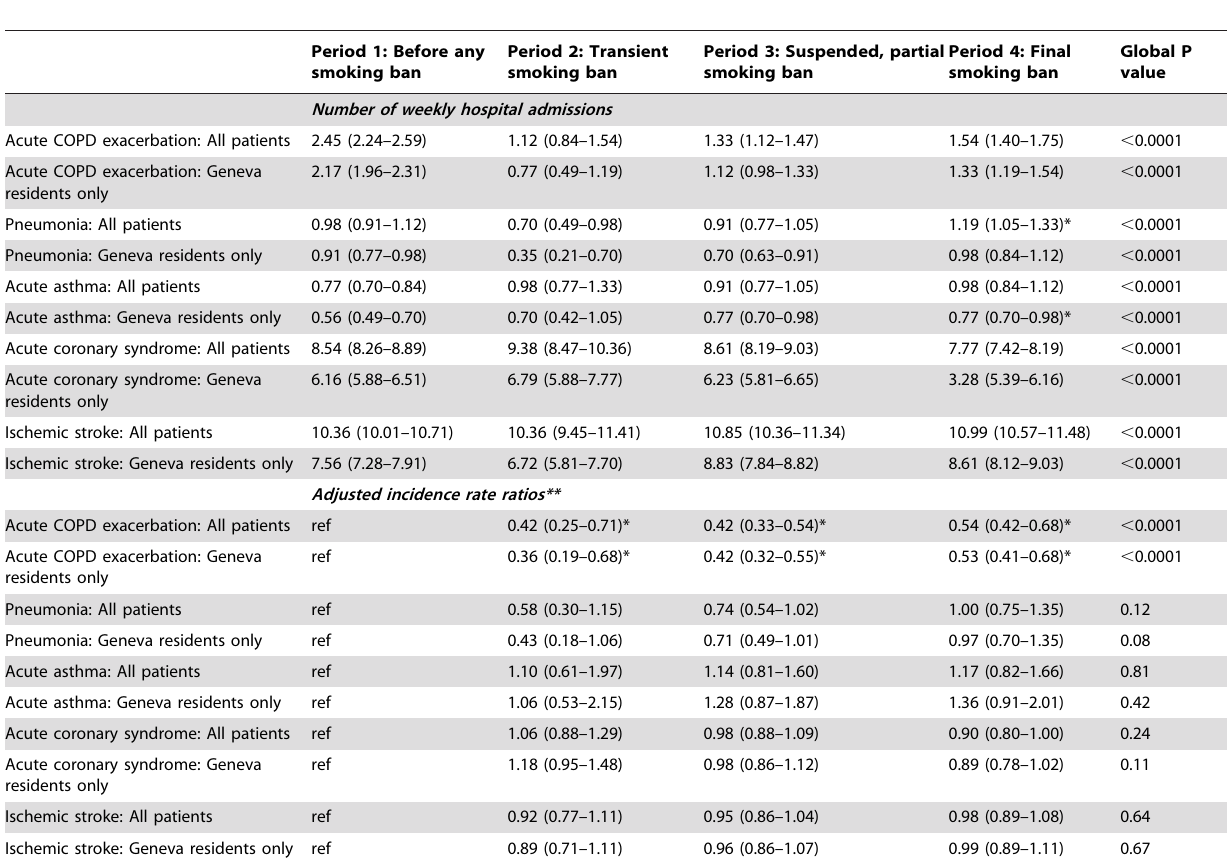
Table 2. Impact of smoking ban on hospitalizations for acute respiratory and cardiovascular diseases for all patients and Geneva residents